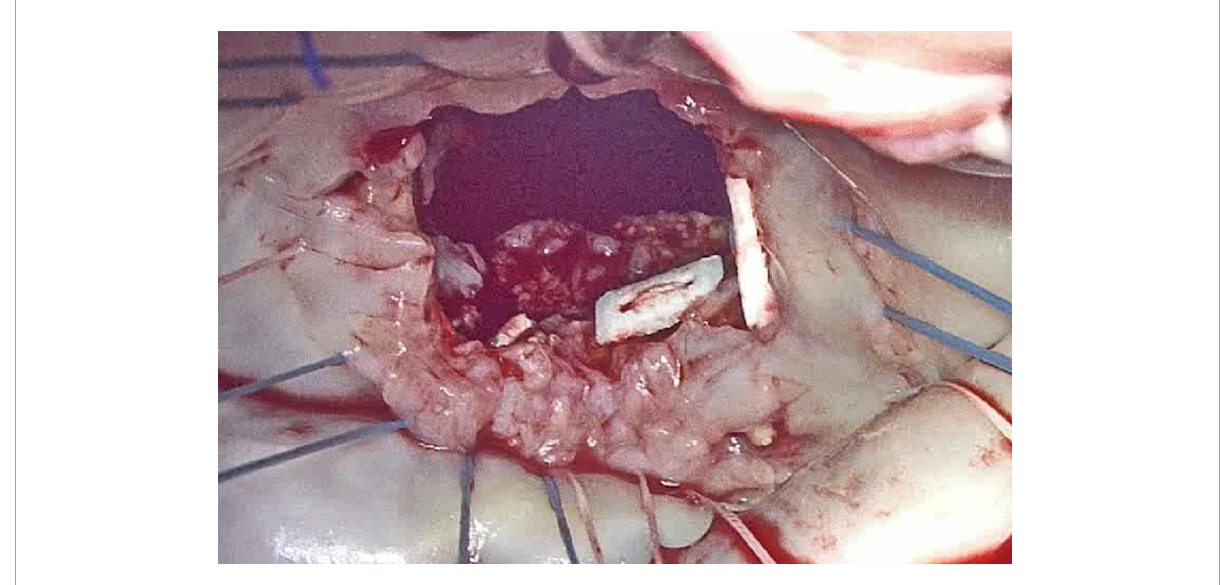
FIGURE3 Intra-operative appearance of mitral annular calcification (MAC) during surgical inspection, after anterior mitral leaflet removal.